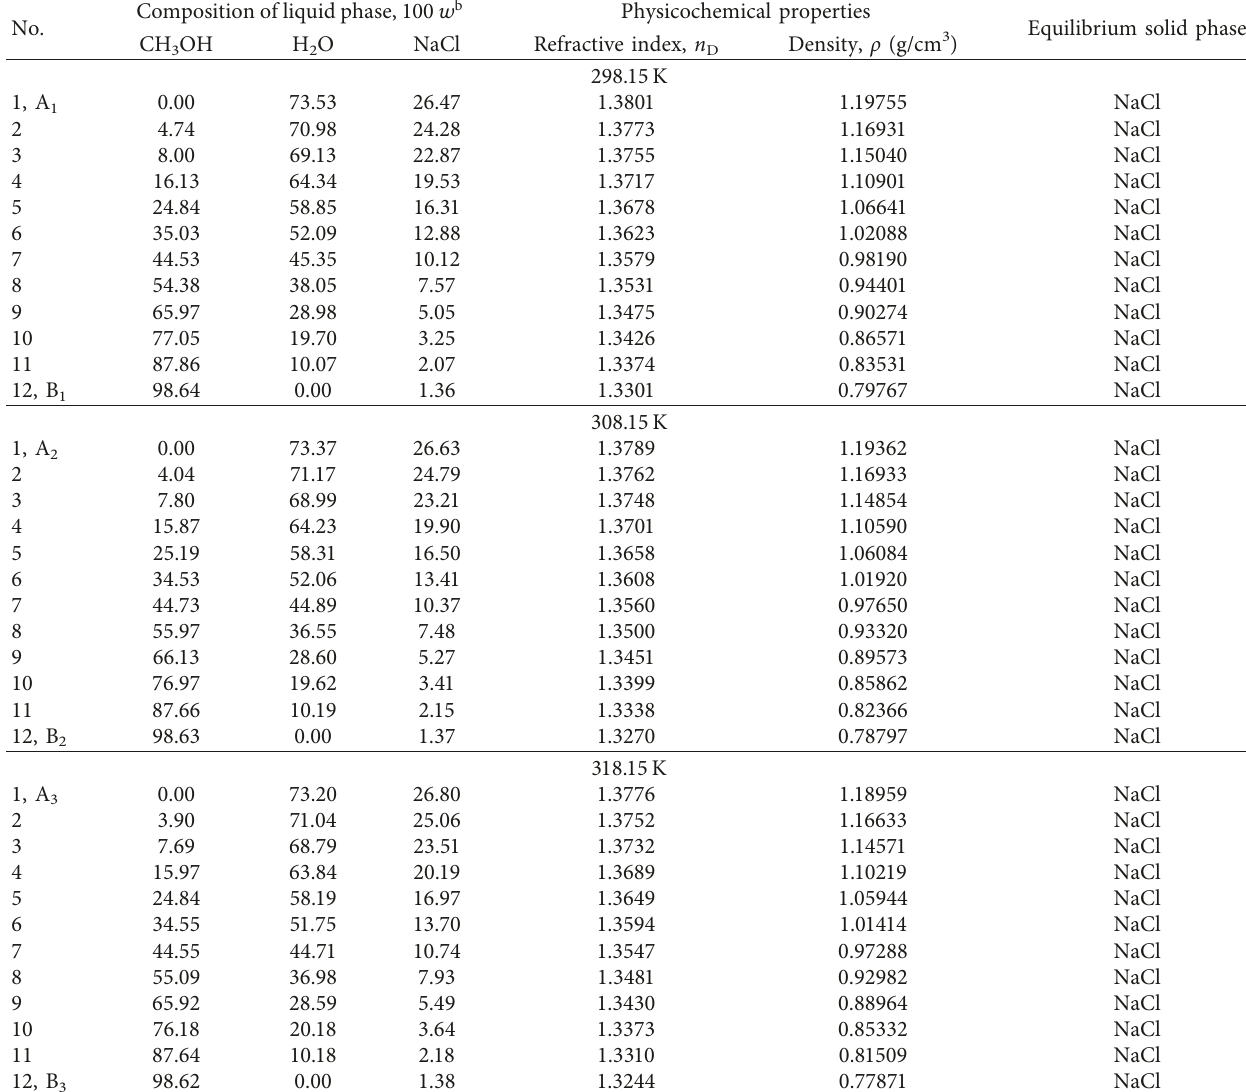
Table 3: The experimental solubilities and the physicochemical properties in the ternary system (NaCl + CH and 318.15 K, and p � 0 . 1MPa.